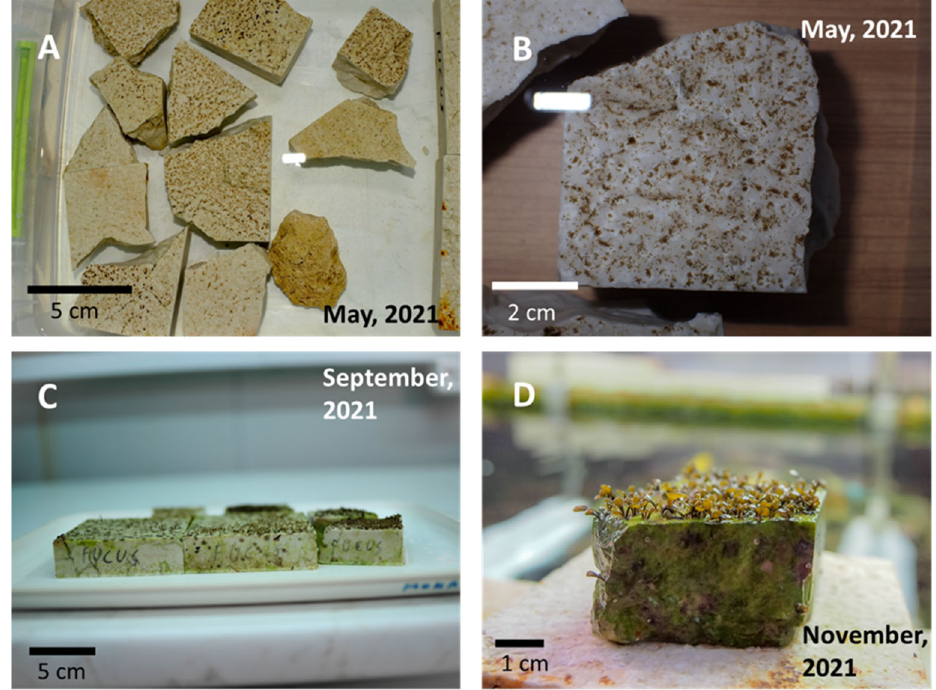
Figure 2. Early growth of Fucus virsoides recruits from May ( A , B ), September ( C ) and November 2021 ( D